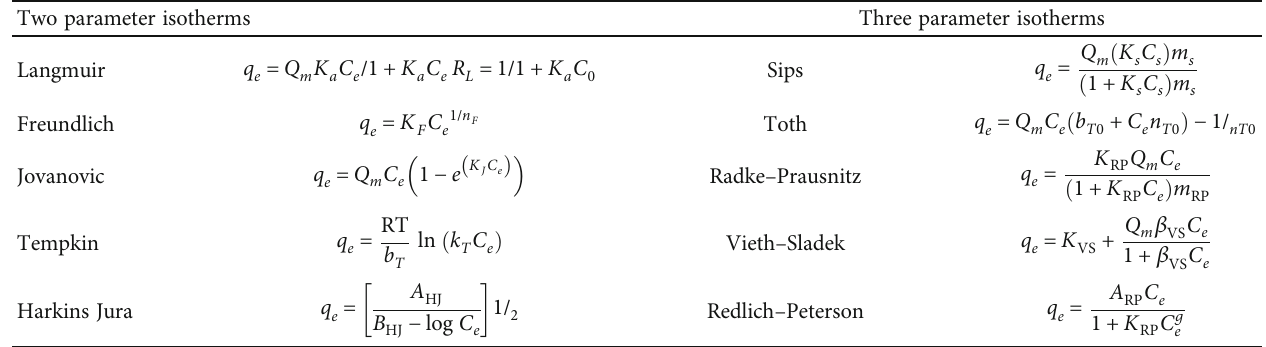
Table 2: Details of two parameters and three-parameter isotherm models.